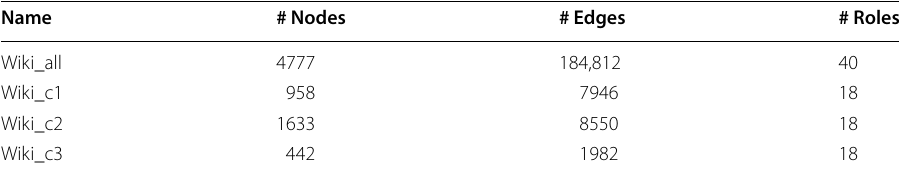
Table 1 Statistics of Wikipedia network and